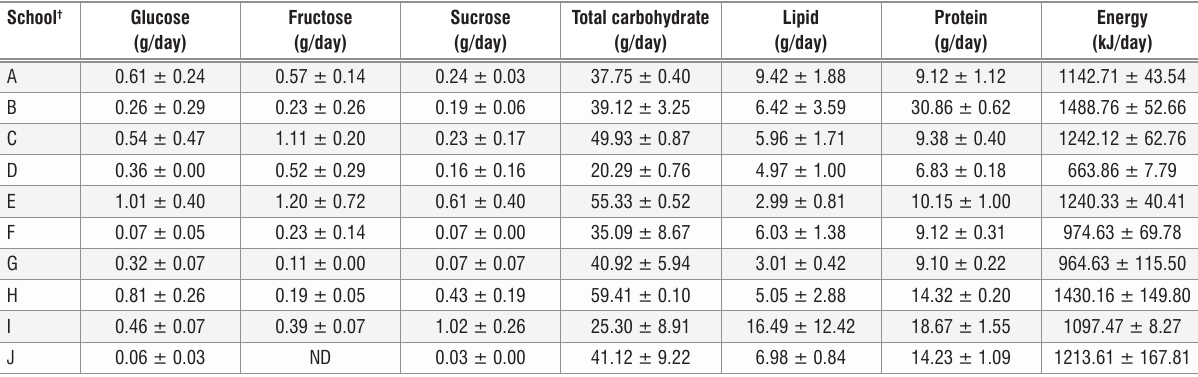
Macronutrient content and energy values of various school meals